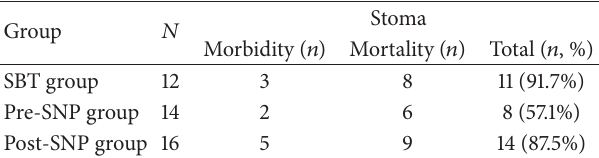
Table 1: Stoma morbidity and